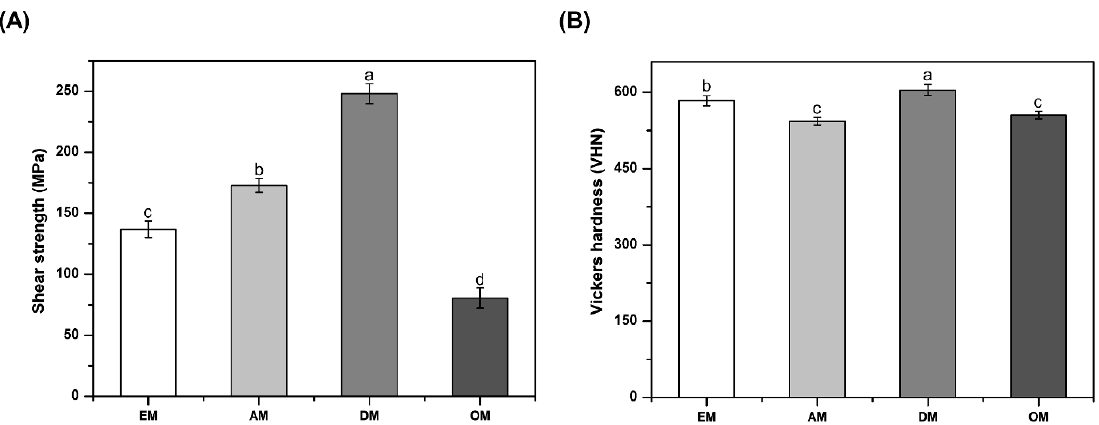
Figure 7. Comparison of shear strength ( A ) and Vickers hardness ( B ) for each group. Differences in lowercase alphabetical letters above the bar graphs indicate significant differences among the groups ( p < 0.05).